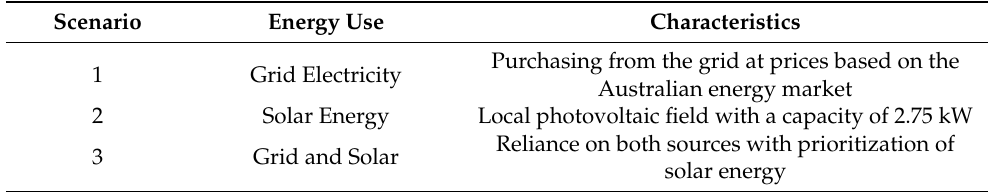
Table 1. Summary of characteristics of the presented